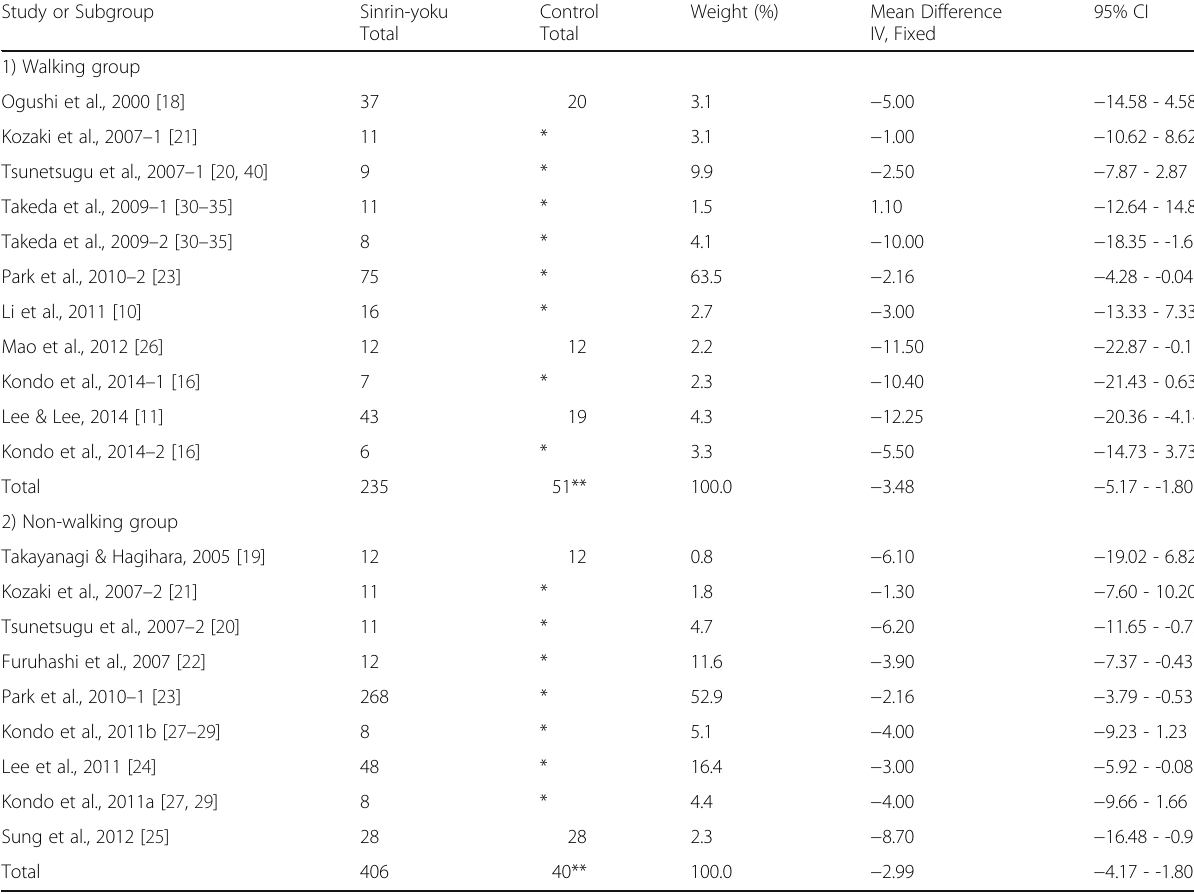
Table 3 Results of the meta-analysis of the change in SBP (mmHg) in the two subgroup analyses of differences in intervention methods (walking and